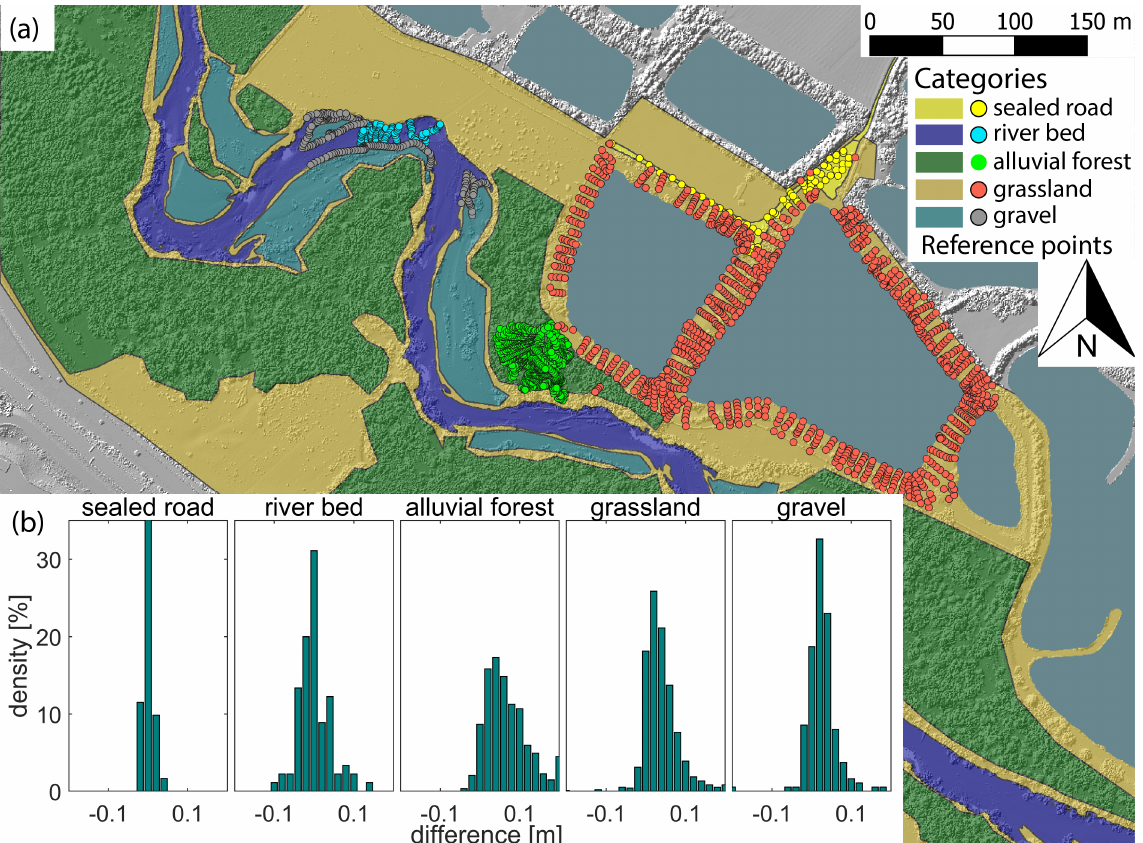
Figure 6. Reference survey for validation of ALB point cloud